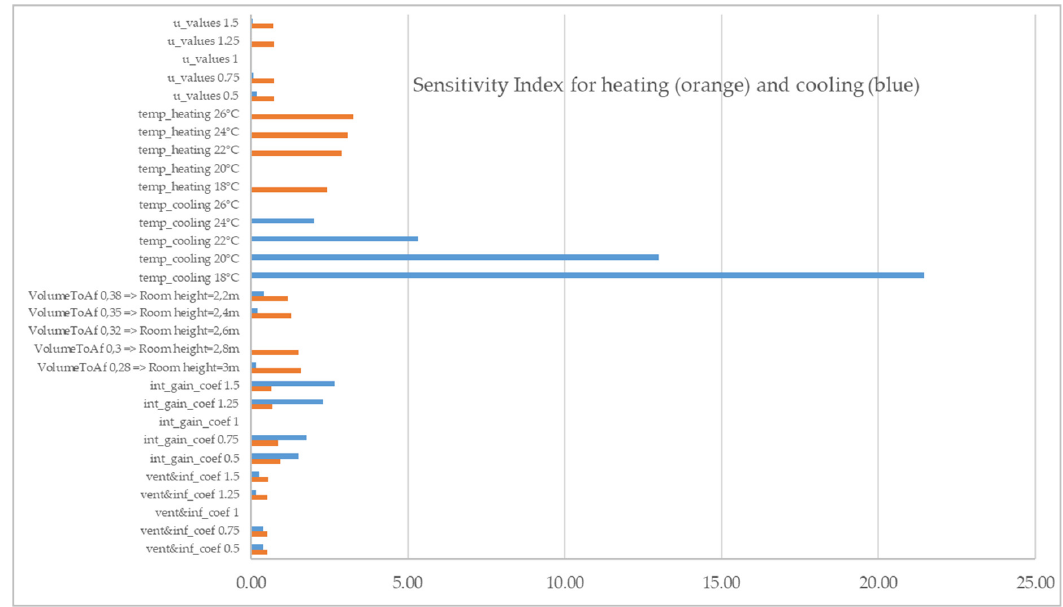
Figure 13. Sensitivity indices for monthly heating and cooling energy needs considering the local method.